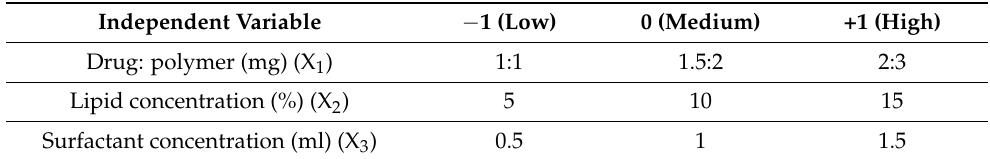
Table 5. Different components employed in formulation of